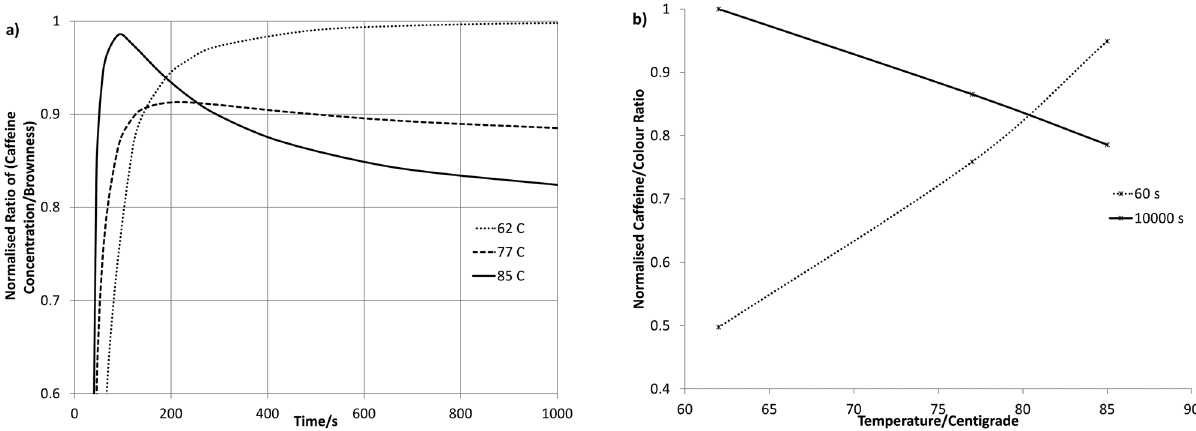
Figure 3: ( a ) How the ratio between ca ff eine and “ brownness ” varies with time. ( b ) Extrapolated data for very short and very long times, suggesting changing the temperature further is likely to have a greater e ff